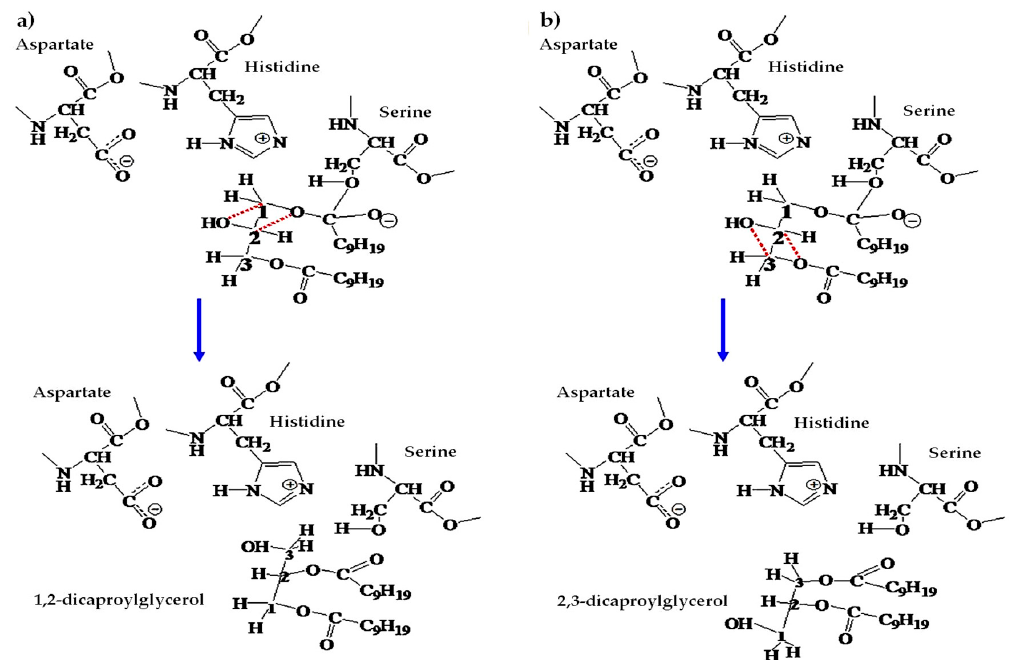
Figure 2. Acyl migration in 1,3-dicaprin. Coordination through position sn-1, ( a ) formation of 1,2-dicaprin by migration mediated by the Serine residue and ( b ) generation of 2,3-dicaprin by migration mediated by the distribution of charges from the environment of the active site.